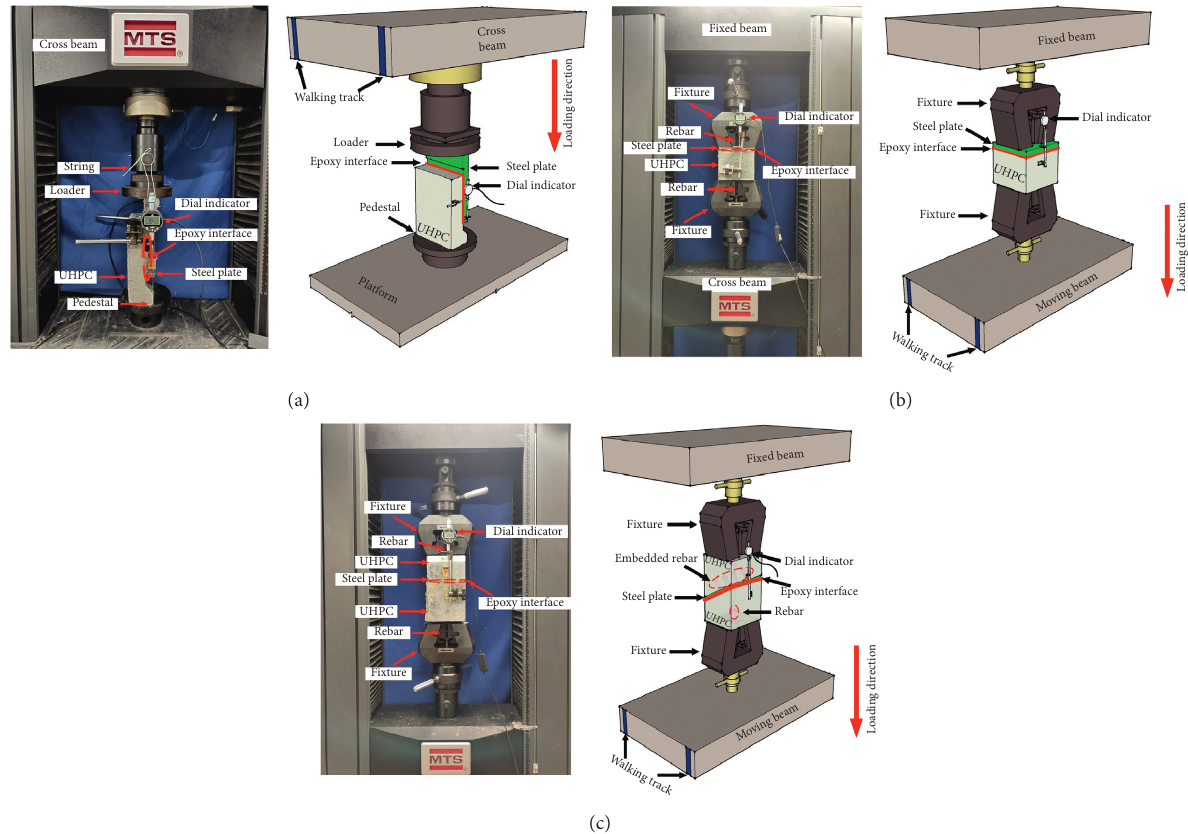
Figure 2: Loading scheme of specimen PS-E, specimen PT-E, and specimen ST-E. (a) Direct shear test. (b) Tensile test. (c) Tensile-shear test.